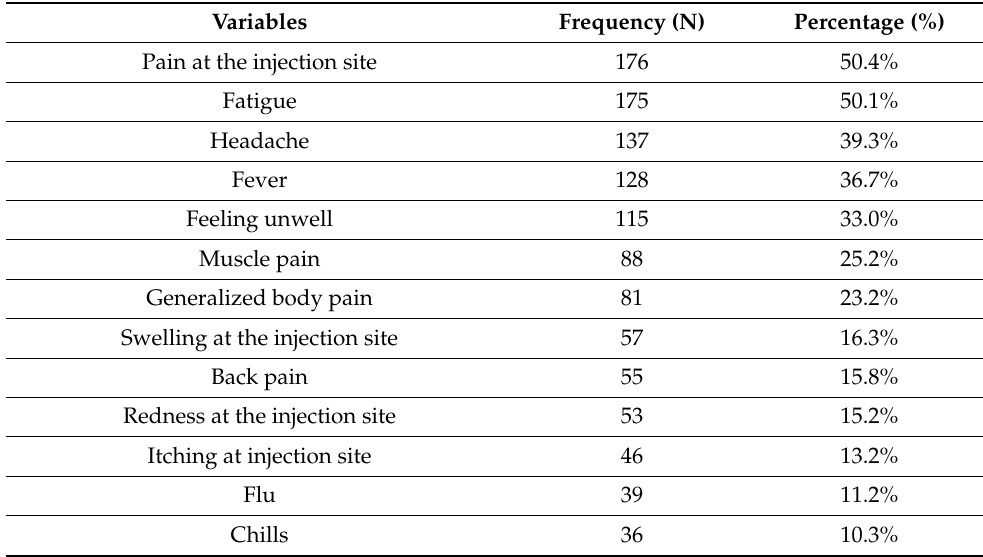
Table 3. Side-effects experienced after first dose of COVID-19 vaccines (N =